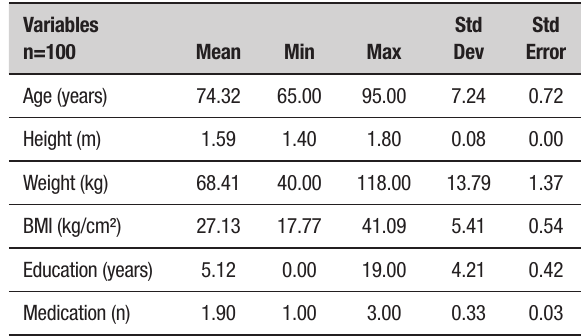
Table 1. Sociodemographic characteristics of final sample of people aged